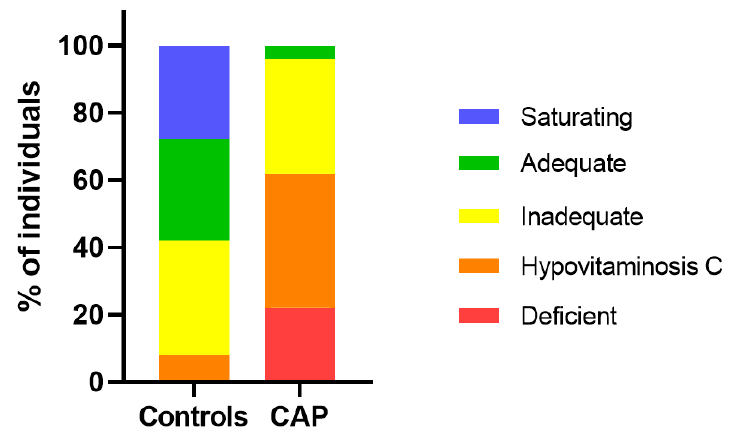
Figure 2. Percentage of individuals from the community-acquired pneumonia (CAP) cohort and healthy controls in di ff erent vitamin C categories. Vitamin C categories are presented as saturating ( > 70 µ mol / L), adequate (between 70 and 50 µ mol / L), inadequate (between 50 and 23 µ mol / L), hypovitaminosis C (between 23 and 11 µ mol / L), deficient ( < 11 µ mol / L). Subsequent samples were collected from 14 (28%) of the participants (mean 2.7 ± 1.7 days, range 1–7 days); there were no statistically significant differences between baseline and subsequent samples for either vitamin C status or protein carbonyl concentrations (Table 3). Table 3. Vitamin C status and protein carbonyl concentrations measured over time.